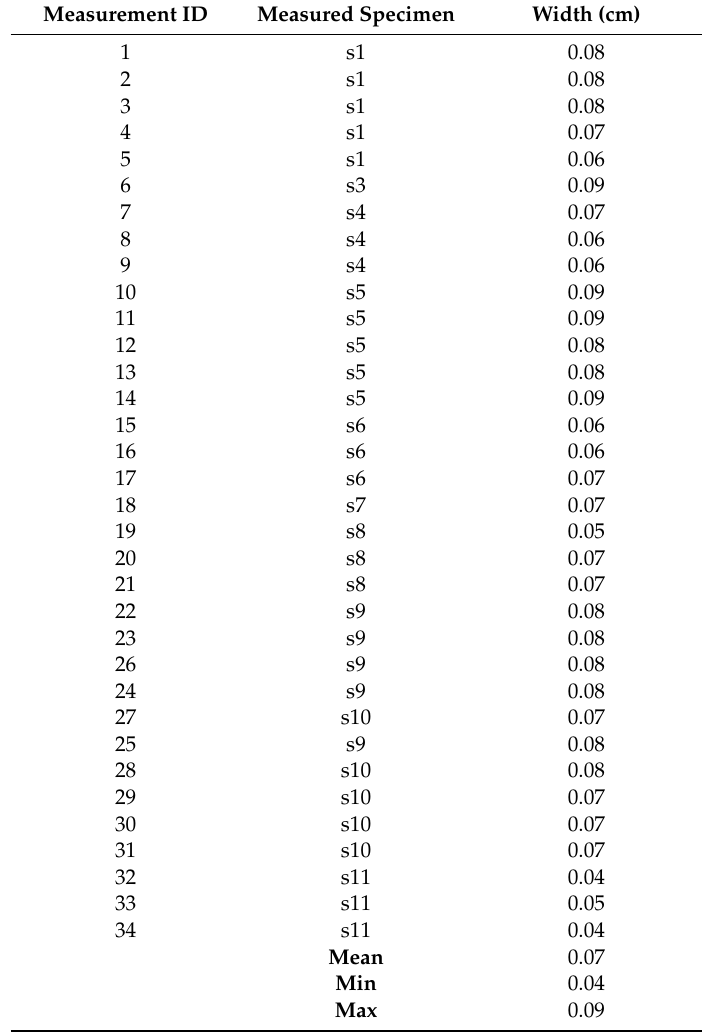
Figure A3. Angle analysis map. Table A1. (following page). Width measures of the stick-like structures from Vera Rubin Ridge, Mars. See Figure A1 for location of measurements.